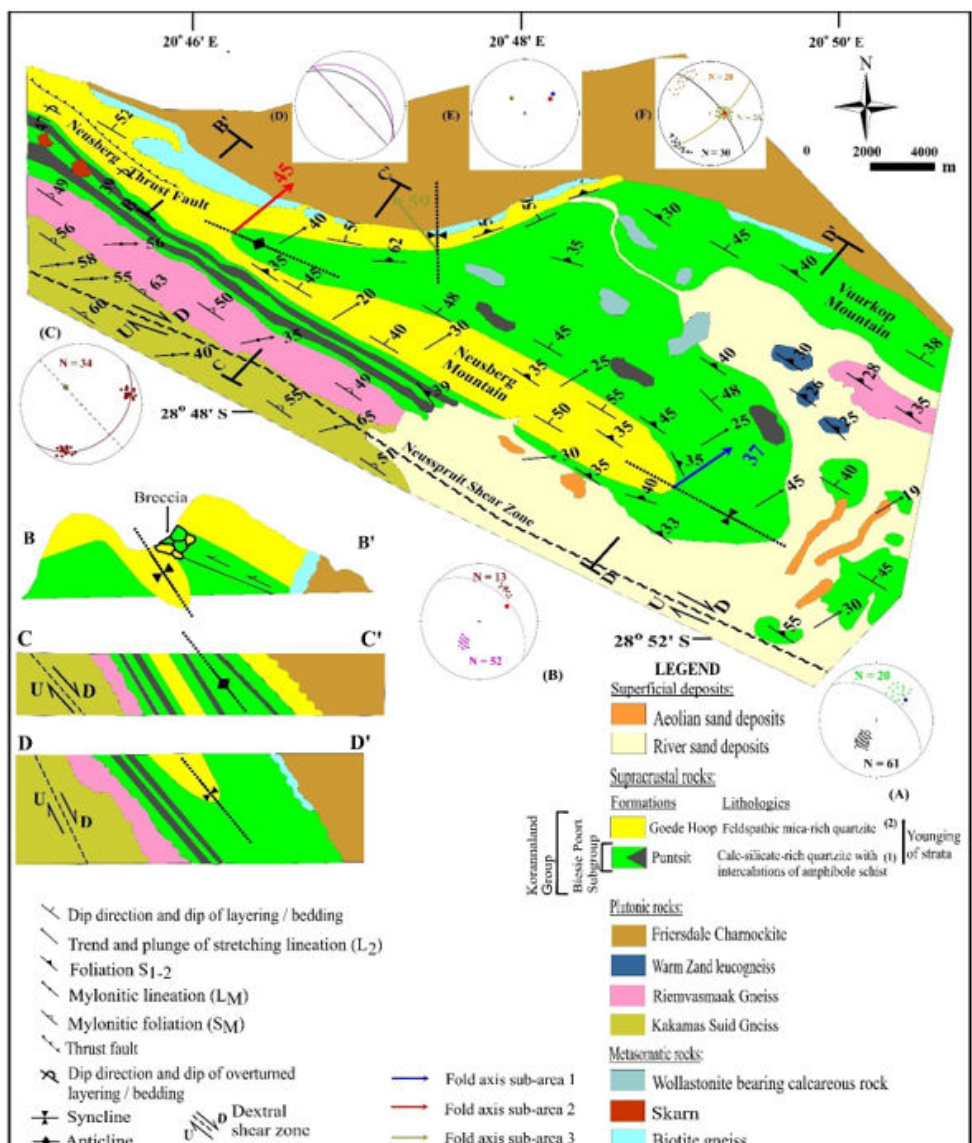
Figure 8. Geological map of the study area displaying the three structural sub-areas within the Neusberg macrofold. Simpli- fied cross-sections B-B’ to D-D’. All stereographic projections are equal-area, lower-hemisphere projections. ( A ) Stereonet shows the plot of poles of S 1 /S 2 foliation (black dots), main foliation plane (black great circle; N = 61), and main fold axis (blue dot; N = 13) of sub-area 1. The stretching lineations L 2 (green dots; N = 20) plunge towards the northeast in sub-area 1. ( B ) Stereonet displays the plot of poles of S 1 /S 2 foliation (pink dots; N = 52), main foliation plane (pink great circle), and main fold axis (red dot; N = 11) of sub-area 2. The stretching lineations L 2 (brown dots; N = 13) plunge towards the northeast in sub-area 2. ( C ) Stereonet showing the plot of poles of the foliation S 1 /S 2 (plum dots; N = 41), best-fit girdle (plum great circle), fold axis (olive green dot) and axial plane (purple dashed great circle) of sub-area 3. ( D ) Stereonet displays the plot of the axial plane of the different sub-areas. ( E ) Stereonet shows the orientation of the fold axes of the various sub-areas. Each plot of the pole is defined by a specific colour (see legend). ( F ) Kinematic interpretation of data along the Neusspruit Shear Zone. The stereographic projection shows the plot of poles of mylonitic foliation (black dots; N = 30), poles of XZ-planes (orange dots; N = 20), and mylonitic elongation lineations (khaki dots; N = 28). The main mylonitic foliation plane is illustrated by a black great circle, and the XZ-main foliation plane is shown as an orange great circle. The small red triangle is indicative of the mean stretching lineation plunging